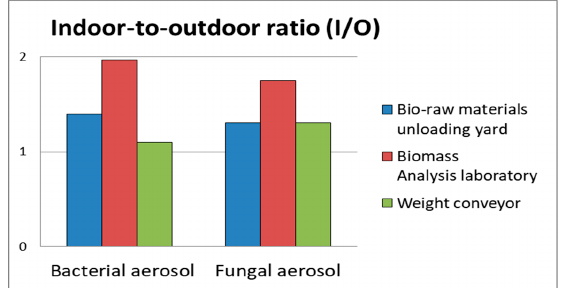
Figure 3. The total average concentration (CFU/m 3 ) of culturable bacteria and fungi in the studied outdoor and indoor air and the values of the indoor-to-outdoor ratio(I/O).